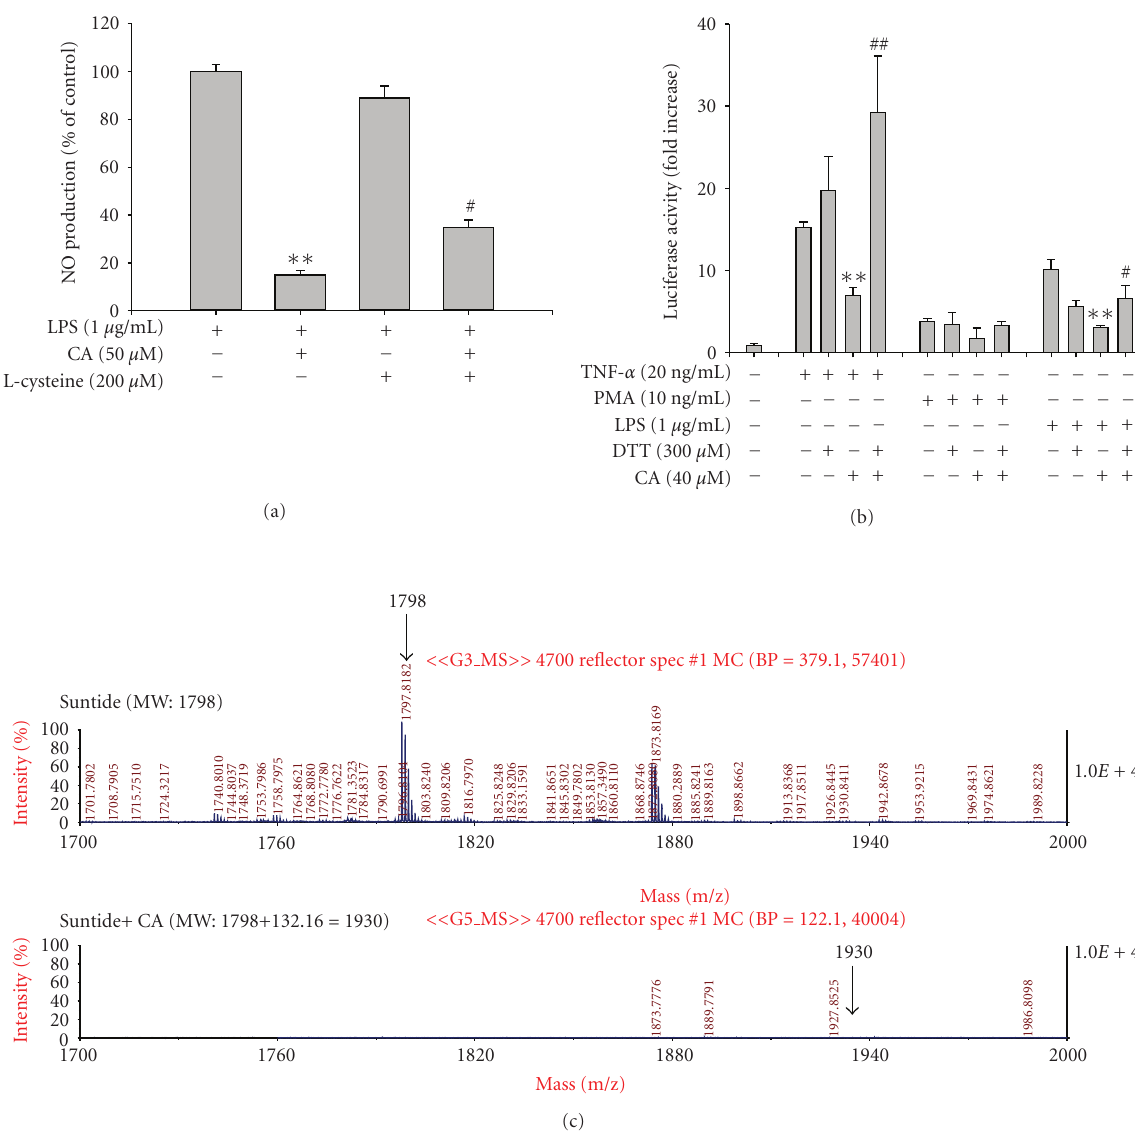
Figure 7: E ff ect of thiol compounds on CA inhibition of NO production and NF- κ B-mediated luciferase activity. (a) RAW264.7 cells (2 × 10 6 cells/ml) pretreated with L-cysteine for 30 min were incubated with indicated concentrations of CA in the presence of LPS (1 μ g/ml) for 24 hours. NO levels in culture supernatant were determined by Griess assay. (b) TLR-4-expressing HEK293 cells cotransfected with the plasmid construct, NF- μ B-Luc (1 μ g/ml), and β -gal (as a transfection control) were treated with CA, L-cysteine or DTT in the presence or absence of TNF- μ , PMA, or LPS for 18 h where luciferase activity was determined by luminometry. (c) CA and Suntide were incubated in kinase assay bu ff er for 30min. The adduct was then identified by MALDITOF/MS analysis. ∗∗ P < . 01 and # P < . 05 represent significant di ff erence compared to control or CA